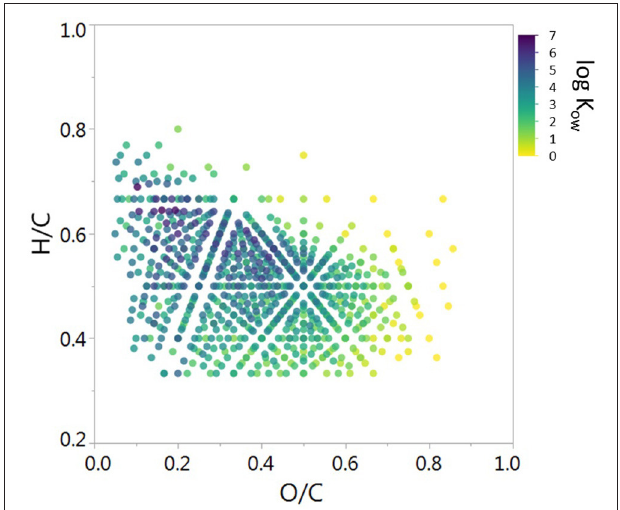
FIGURE 5 | Van Krevelen diagram of assigned DBC molecular formulae in the water leachate of PA2 Soil. Points are colored according to the estimated K ow calculated from C + H-O regressions.